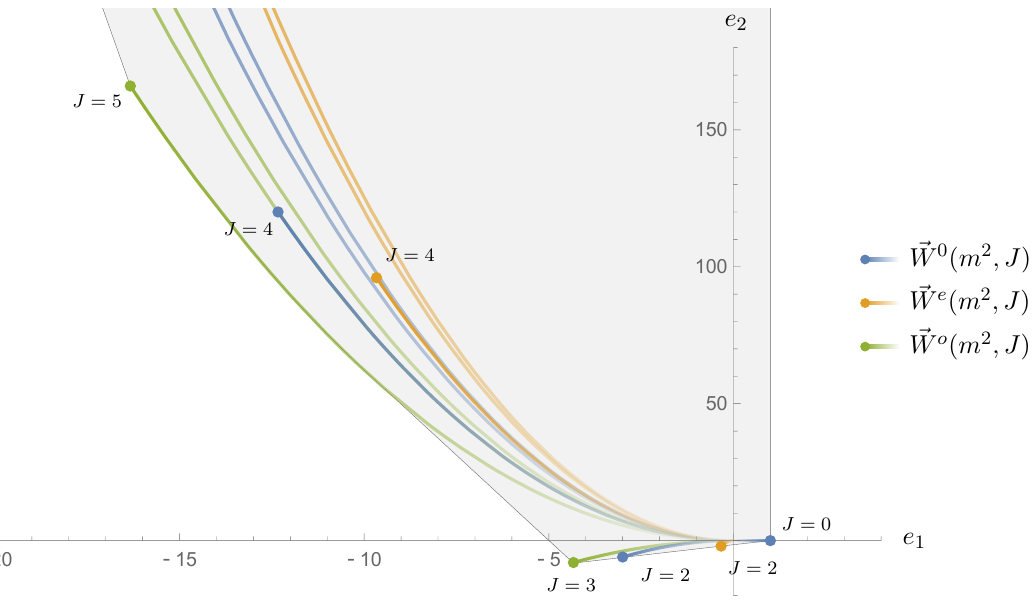
Figure 7 . Plot showing the convex hull of points in the right-hand side of equations (B.3) and (B.4). The bound (4.7) is the intersection between the shaded region and the e where M 2 = 1